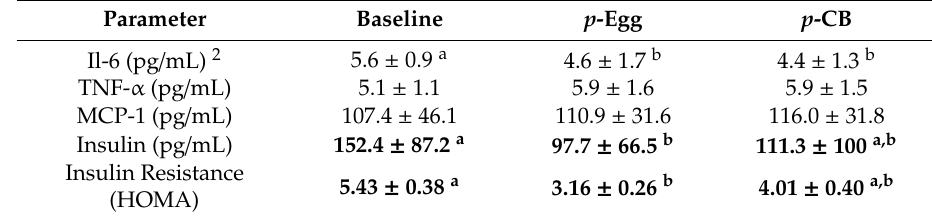
Table 5. Plasma IL-6, TNF-, and MCP-1 in subjects at baseline post ( p ) intervention with egg and choline bitartrate (CB) supplement 1 .